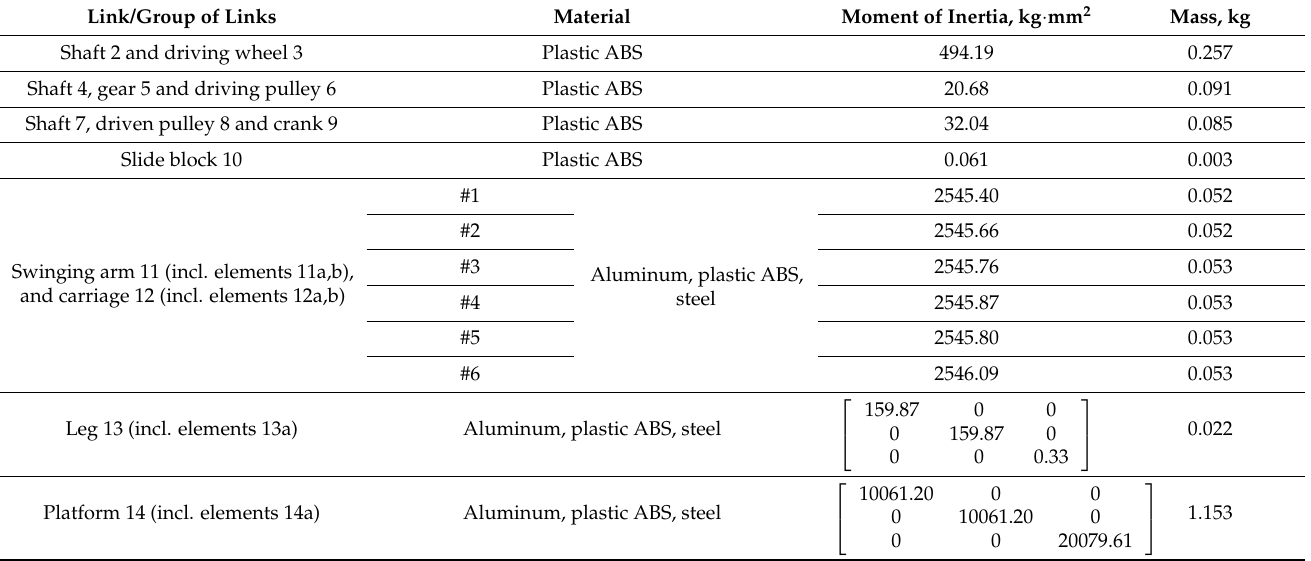
Table 3. Inertial properties of the hexapod links.